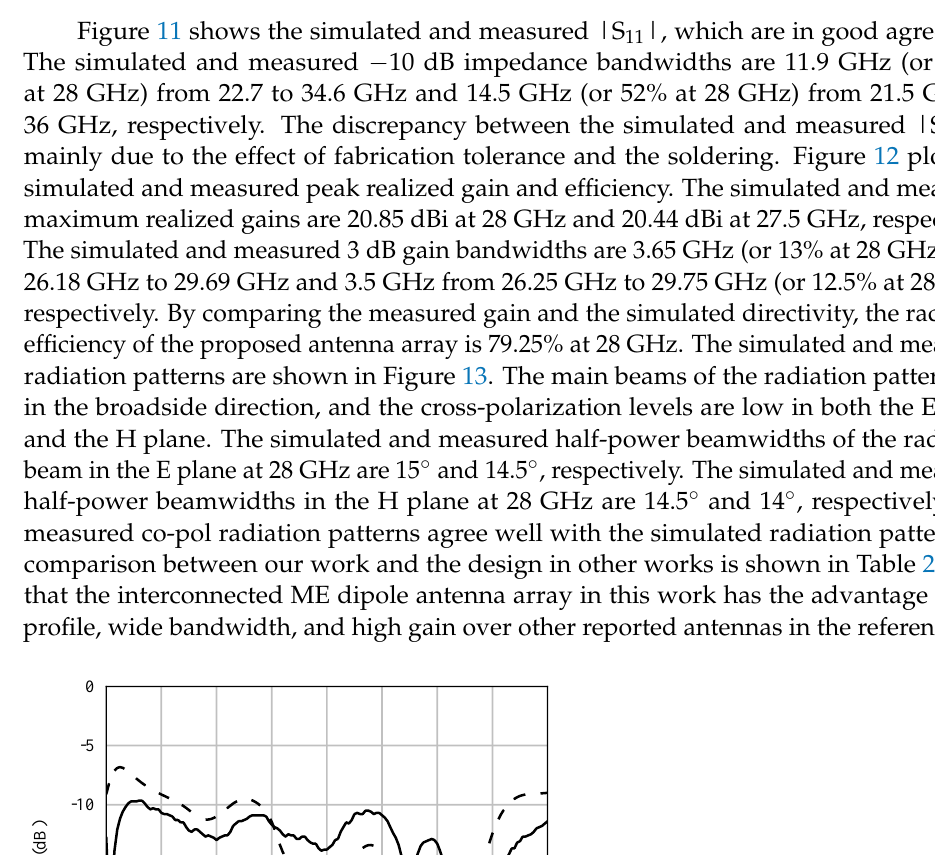
Figure 10. Fabricated 5 × 5 interconnected ME dipole antenna array. The ( a ) fabricated prototype and ( b ) antenna under test.